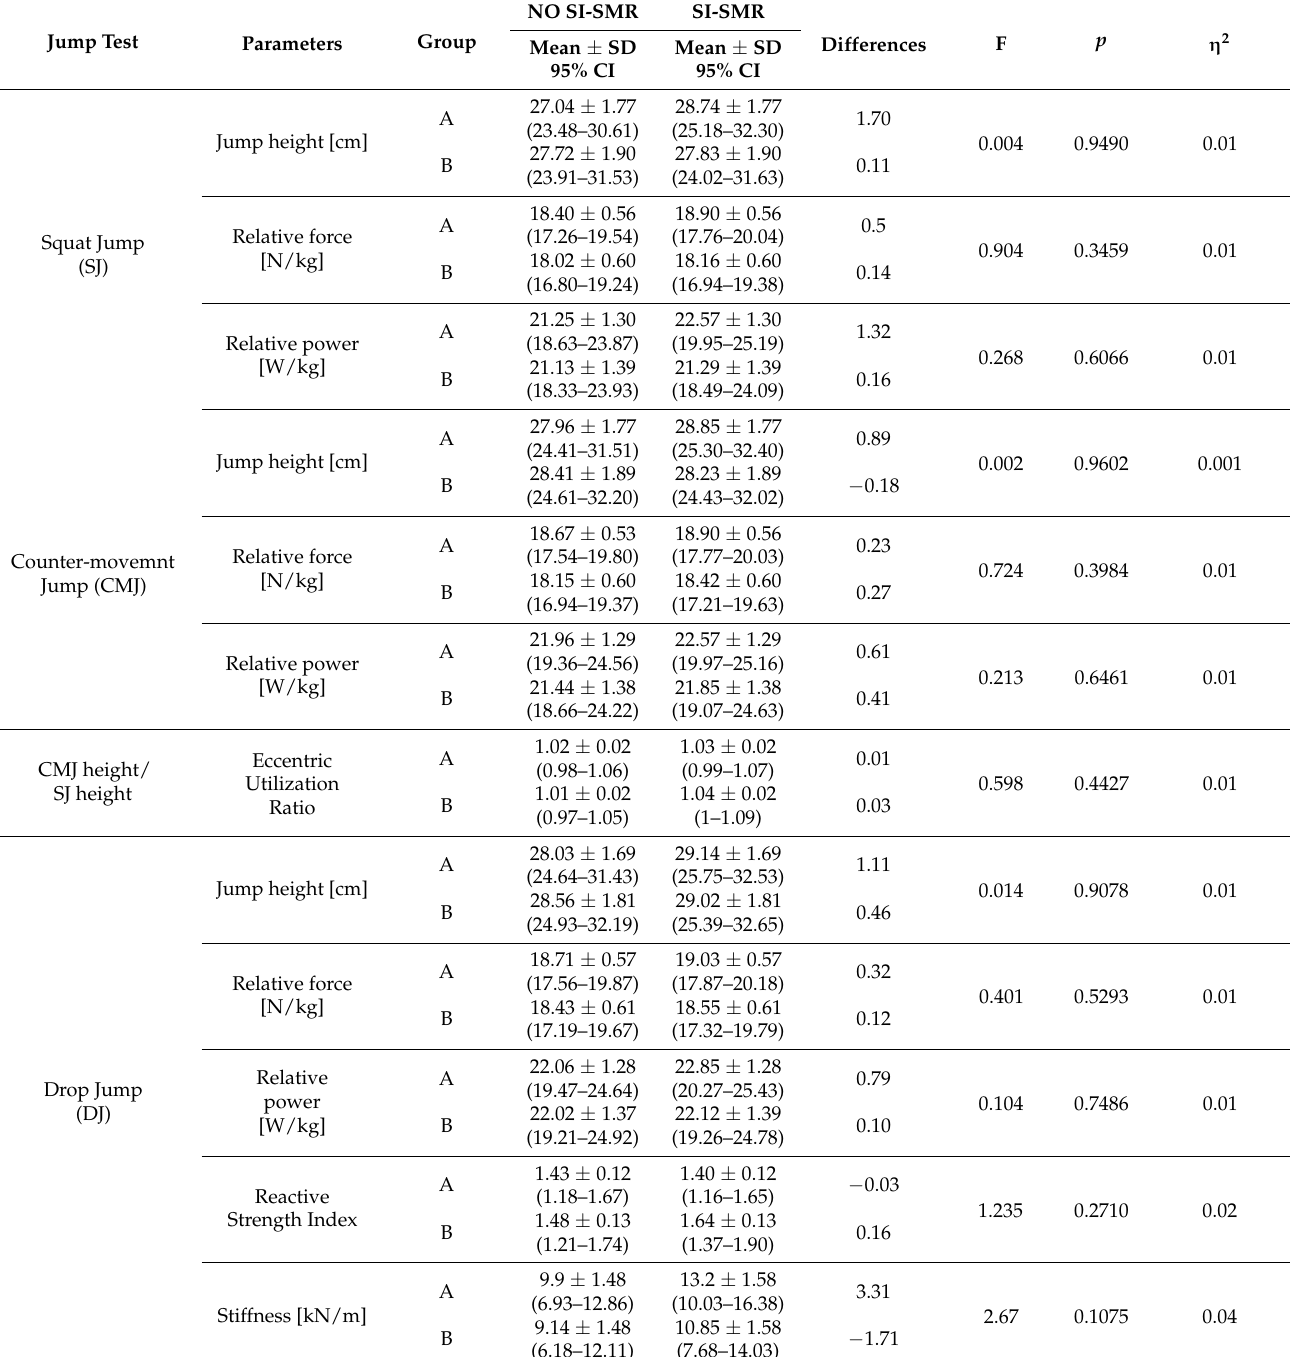
Table 3. Pre-to post-intervention changes in jump parameters results of a two-way repeated measures